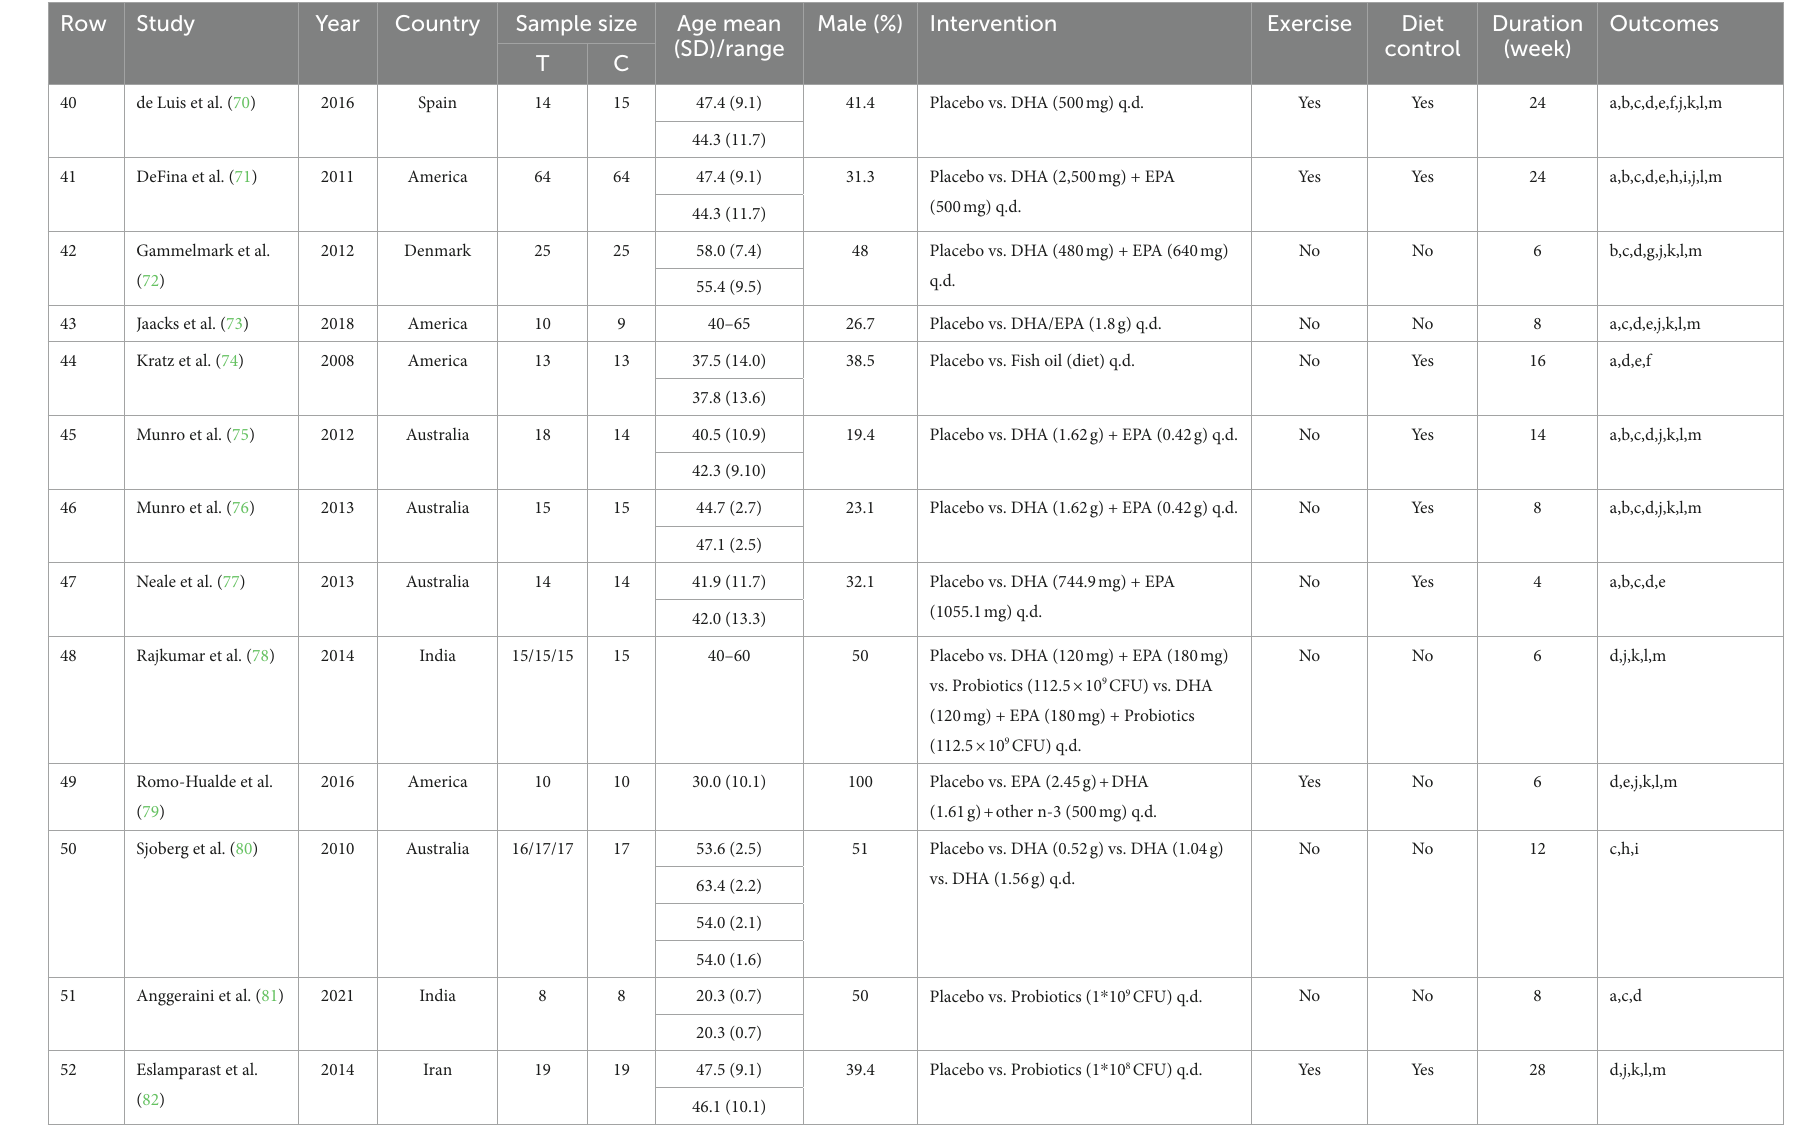
Placebo vs. Probiotics (1 * 10 9 CFU)